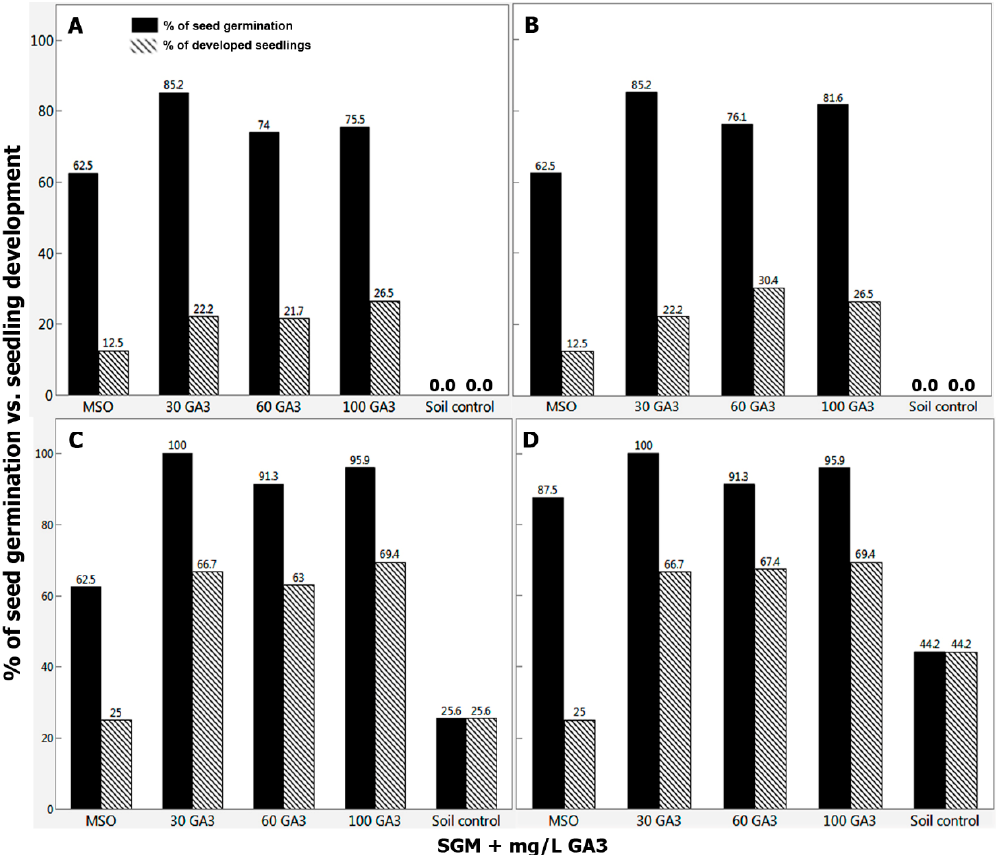
Figure 5. (Exp. II in 2019 / 2020). Percentage of M. autumnalis seed germination and of fully developed healthy seedlings within ( A ) 14 days; ( B ) 18 days; ( C ) 30 days; ( D ) 72 days of the in vitro cultured decoated seeds ( n = 16–49) vs. intact seeds sown in potting soil (soil control), ( n = 43). The intact seeds were stored at 4–5 °C.